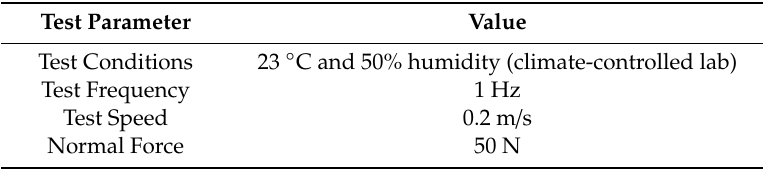
Table 3. Boundary conditions of the